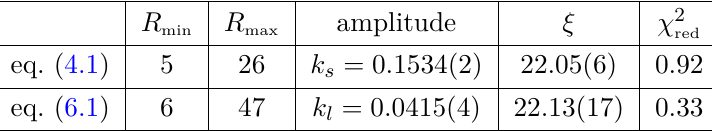
Figure 2 . Fit of the Monte Carlo results obtained at N t = 9 , β = 12 . 15266 , T/T to the short-distance approximation of the spin-spin Ising correlator of eq. (4.1). R min